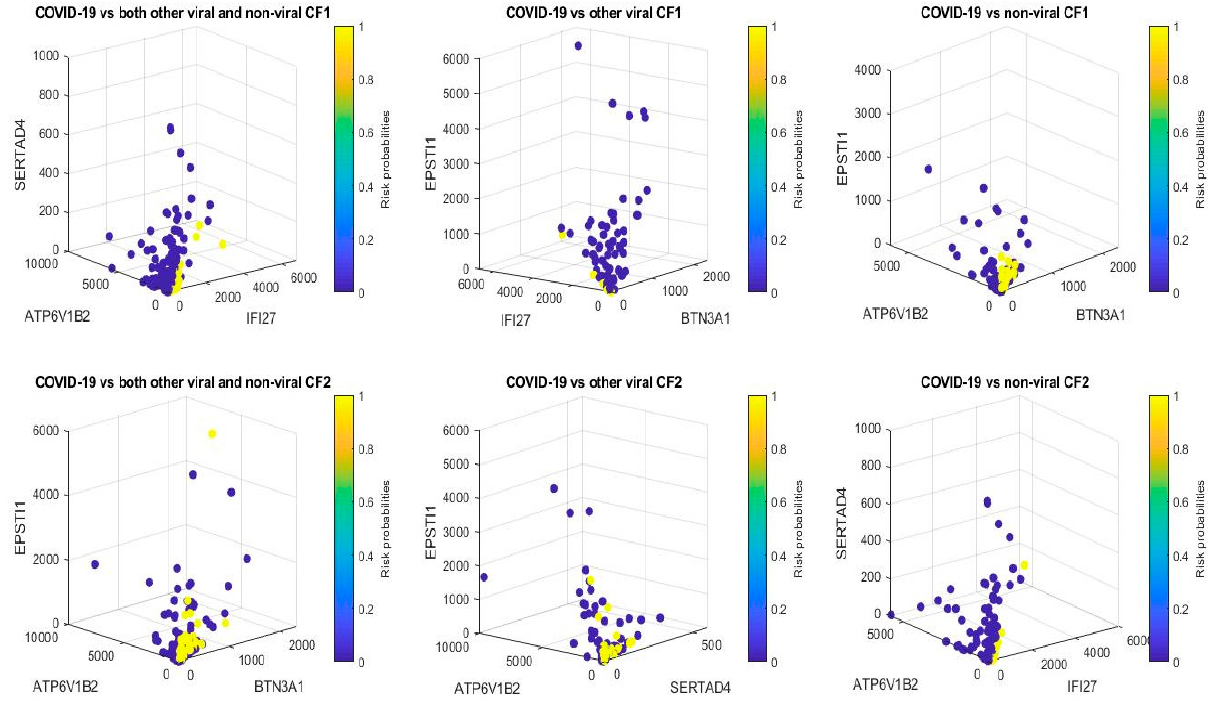
Figure 1. COVID-19 classifiers in Tables 3–5: Visualization of gene–gene relationship and gene-risk probabilities. Note that 0.5 is the probability threshold.